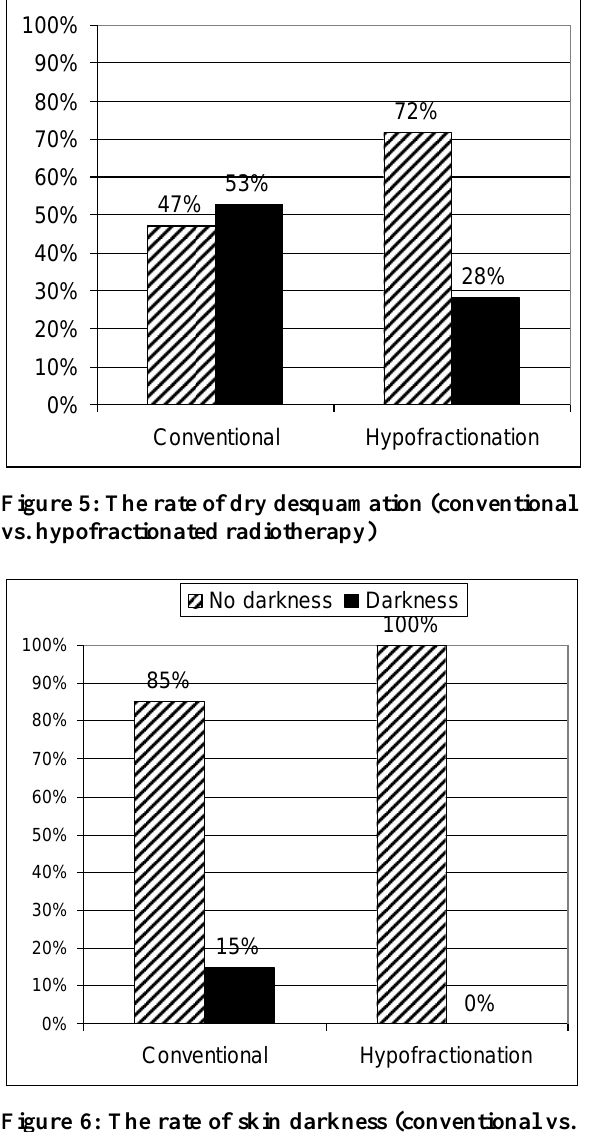
Figure 6: The rate of skin darkness (conventional vs. hypofractionated